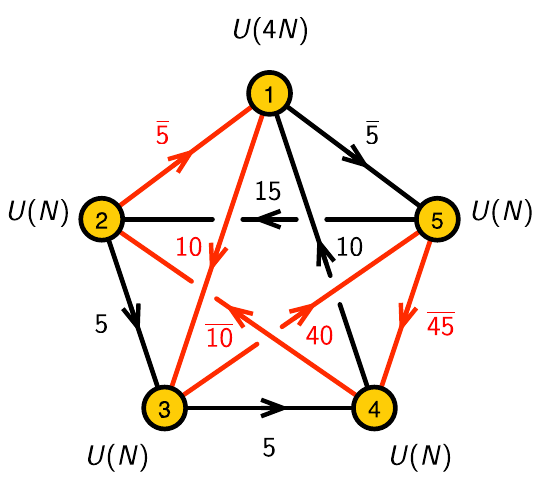
Figure 14 . Quiver diagram for local CP 4 obtained from the one in (cid:12)gure 13 by acting with quadrality on node